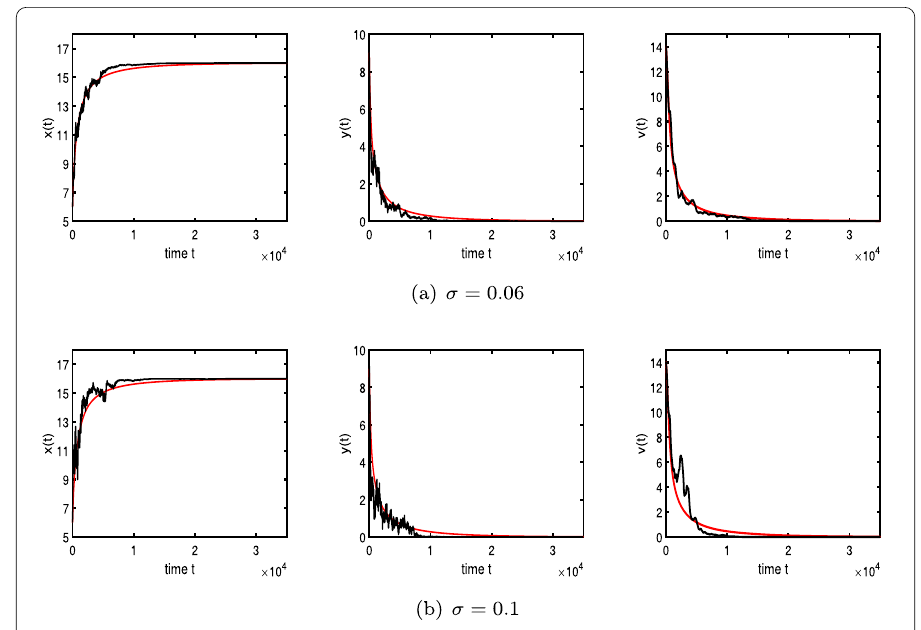
Figure 1 Given R 0 < 1, the relationship between trajectories of deterministic model (1.1) and stochastic model (1.2)